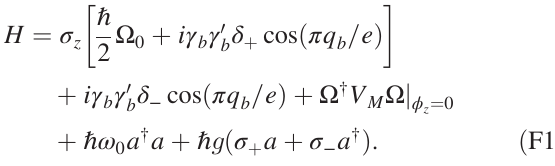
ffiffiffiffiffiffiffiffiffiffiffiffiffiffiffiffiffiffiffiffiffiffiffiffiffi p 8 E Φ J;b ð max Þ =E C;b